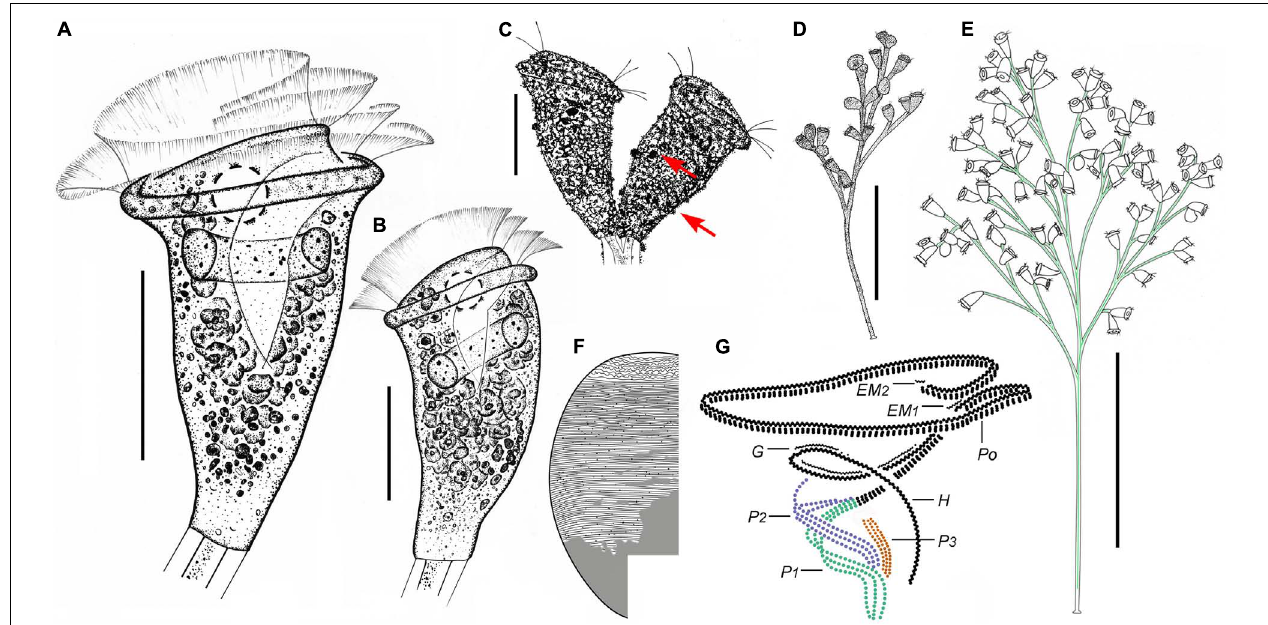
FIGURE 4 | Zoothamnium hentscheli in vivo (A–E) , after “dry” silver nitrate staining (F) , and after protargol staining (G) . (A,B) Different zooids showing the shape variation. (C) Arrows mark the pellicle with attached detritus. (D) A developing colony covered with detritus. (E) A mature colony; the structure in green is the spasmoneme. (F) Silverline system. (G) Oral ciliature. EM1, 2, epistomial membrane 1, 2; G, germinal kinety; H, haplokinety; Po, polykinety; P1–3, infundibular polykineties 1–3. Bars: 35 µ m in panels (A–C) , 300 µ m in panel (D) , and 500 µ m in panel (E)